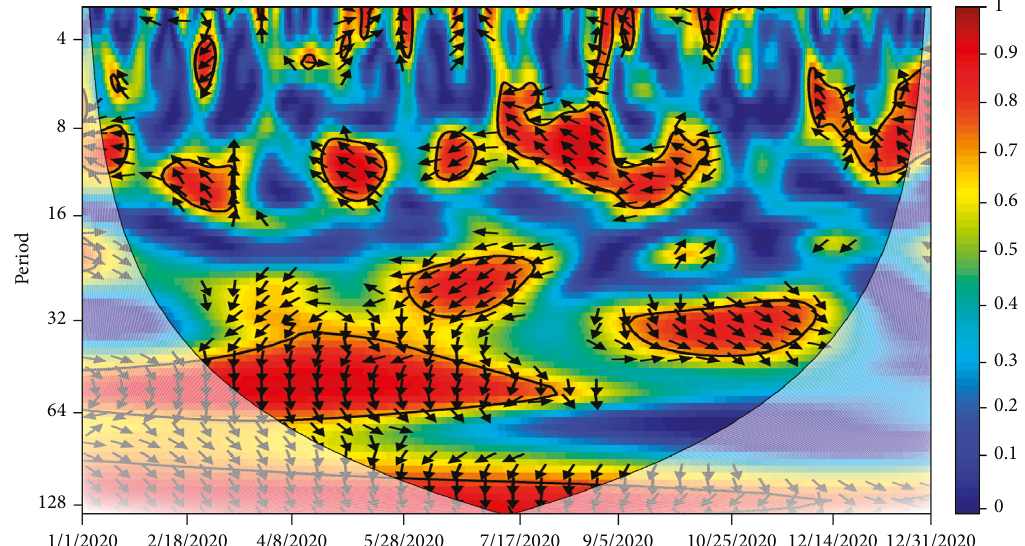
Figure 6: The wavelet coherency between illiquidity and EPU (pandemic period). Note: this figure reports the wavelet coherency between illiquidity and EPU during pandemic period. The black contour represents the regions in which the spectrum is significant at the 5% level against red noise. The cone of influence denoted as COI is designated by the lighter shade which delineates the high power regions. Time and scale (days) are represented on the horizontal and vertical axes, respectively. Arrows pointed to the right (resp. left) signify that the variables are in phase (out of phase). If arrows move to the right and up (resp. down), the first variable is the driver (resp. follower). By contrast, if arrows move to the left and up (down), the second variable is leading (resp. lagging).